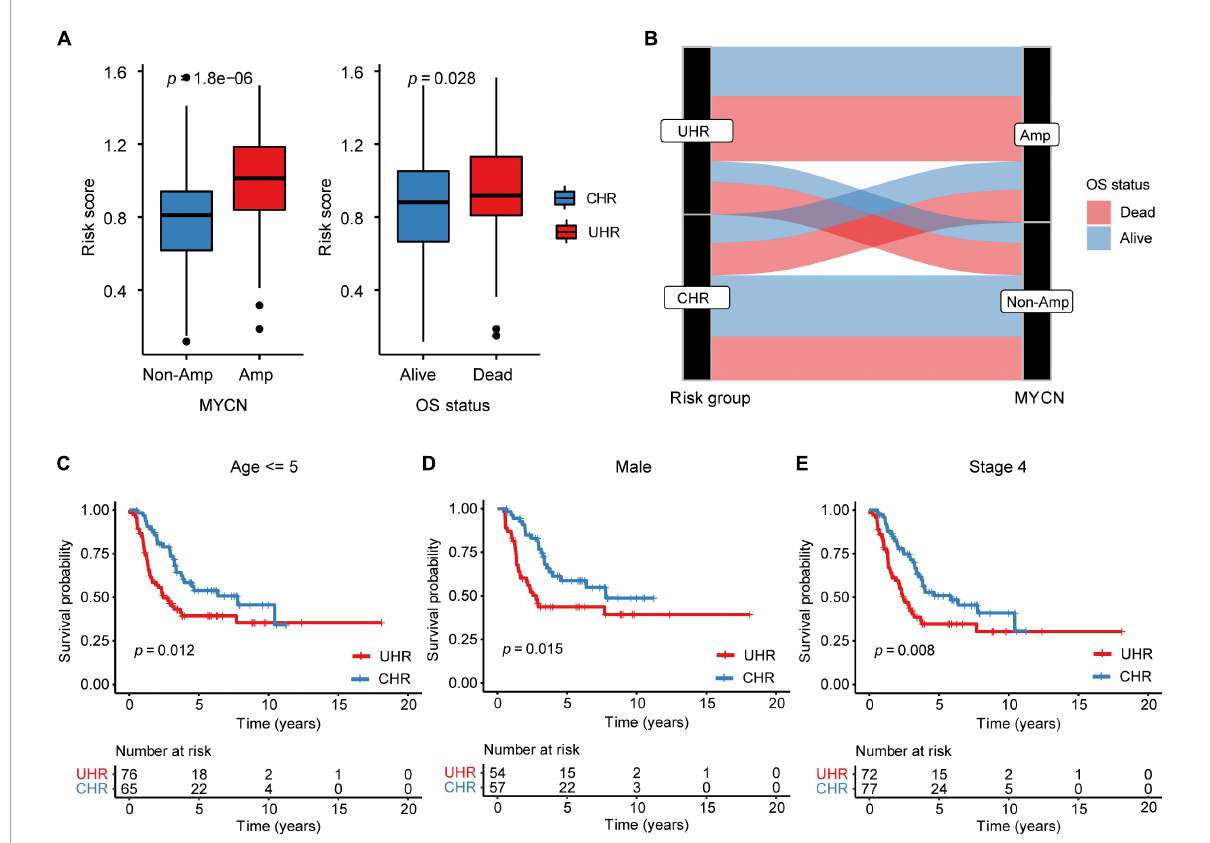
FIGURE4 The relationship between MMGS risk score and clinical variables in the SEQC cohort. (A) The relationship between MMGS risk score and MYCN status, OS status. (B) Sankey diagram showing the association between MMGS risk score, MYCN status, and OS status. KM curves of OS between UHR and CHR patients with age less than 5 years old (C) , male (D) , and stage 4 (E) , respectively. Amp,